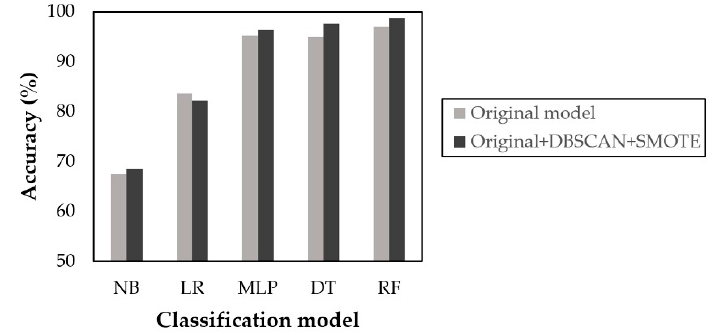
Figure 10. DBSCAN and SMOTE impacts for classification accuracy. NB = Naïve Bayes, LR = logistic regression, MLP = multilayer perceptron, DT = decision tree, RF = random forest. The generated hybrid fault model was installed onto the edge devices to provide fault